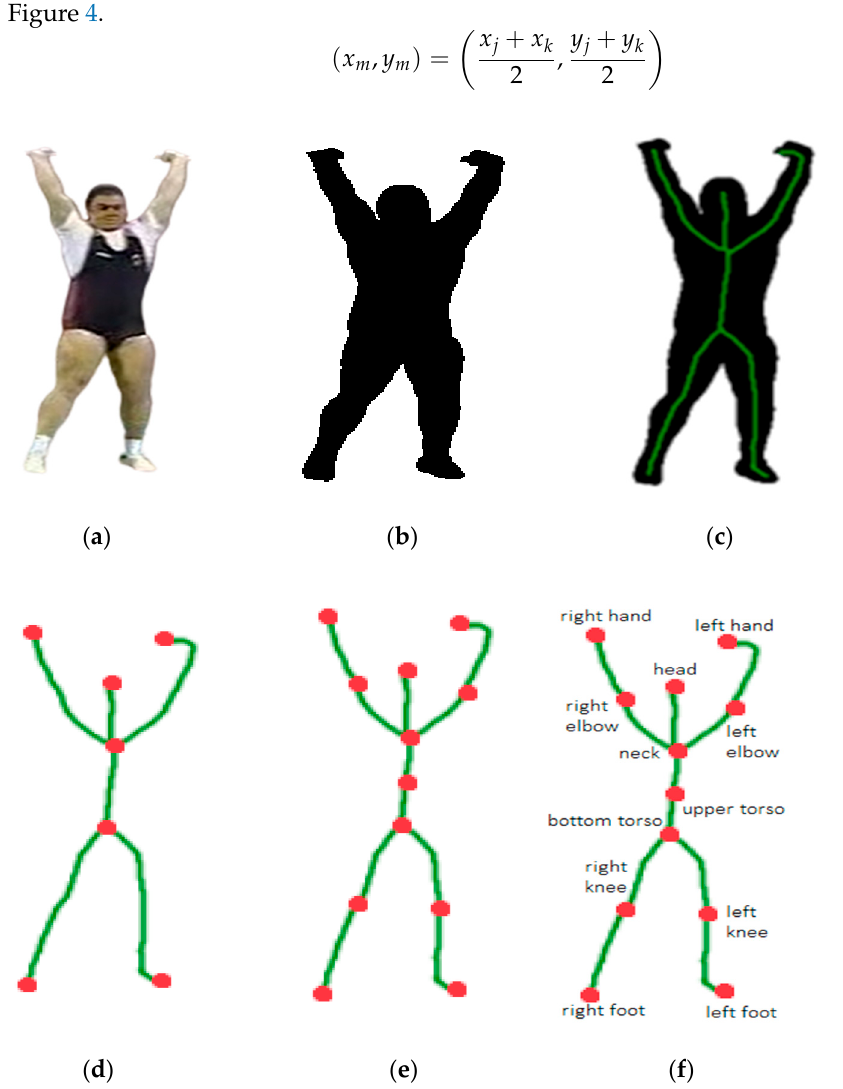
Figure 4. Results of key point detection. ( a ) Full body silhouette, ( b ) binary silhouette, ( c ) IFT graph, ( d ) graph nodes, ( e ) additional nodes, ( f ) 12 key body points.